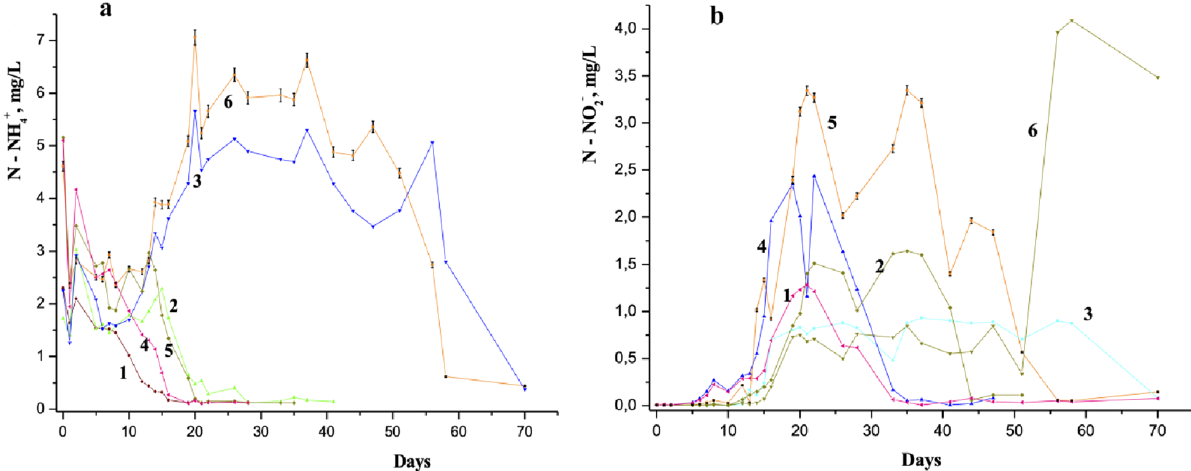
Figure 5. ( a ) Dynamics of the ammonium ion concentration in the Nistru River (Vadul-lui-Voda section) water on the modeling with 3 mg/L NH 4+ (1—the reference sample, 2—with 2.0 mg/L, 3—with 20.0 mg/L DEA) and 6 mg/L NH 4 + (4—the reference sample, 5—with 2.0 mg/L, 6—with 20.0 mg/L DEA)initially. ( b ) Dynamics of the nitrite ion concentration in the Nistru River (Vadul-lui-Voda section) water on the modeling with 3 mg/L NH 4 + (1—the reference sample, 2—with 2.0 mg/L, 3—with 20.0 mg/L DEA) and 6 mg/L NH 4 + (4—the reference sample, 5—with 2.0 mg/L, 6—with 20.0 mg/L DEA)